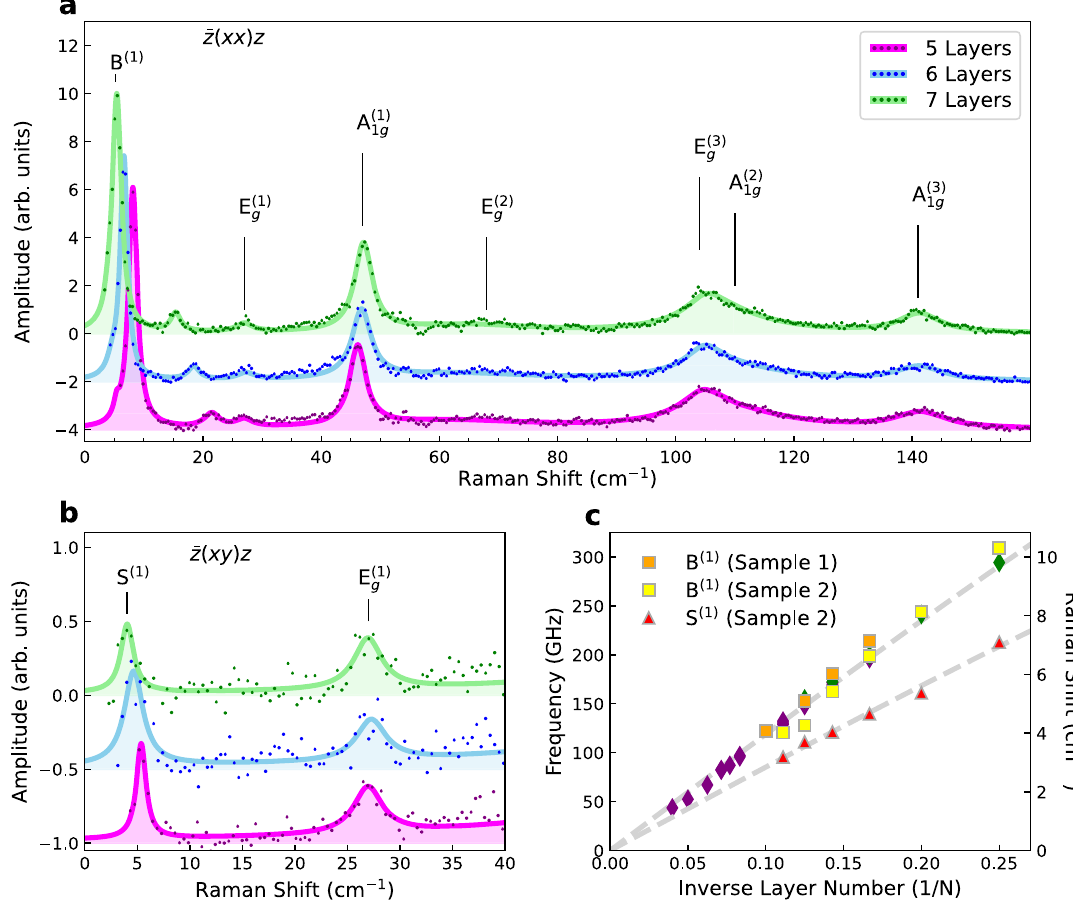
Fig. 4 Polarized Raman measurements on MnBi 2 Te 4 . With parallel polarization ( a ), the data contains 6 peaks at high frequencies which match previously reported Raman data, as well as a very large low-frequency peak corresponding to the phonon breathing mode, labeled B (1) . The Rayleigh scattering background is subtracted. In the cross-polarized con fi guration ( b ) this large peak vanishes, and an additional peak corresponding to the shear mode, labeled S (1) , is revealed. Plotting the frequency of the B (1) and S (1) peaks as a function of thickness ( c ) along with the previously shown time-resolved data (purple and green diamond symbols for Samples 1 and 2 respectively) shows a good agreement of the breathing mode with the time-resolved data as well as a good fi t of the shear mode to the linear chain model with f 0 ,S = 545 GHz. Although the statistical uncertainties remain small ( ≈ 0.1% for B peaks and ≈ 1% for S peaks), compared to the time-resolved data the extracted peak locations show more variation, probably due to the in fl uence of the background, which is very large at such low